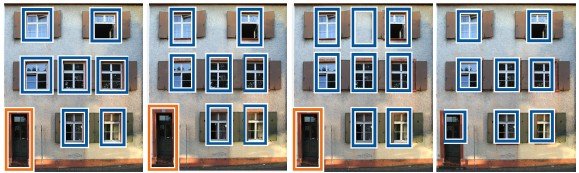
Figure 5: Results for varying parameters. From left to right: groundtruth | results, using the datasets setting λ 1 = λ 2 = 0 . 3 | λ 1 = λ 2 = 1 | λ 1 = 0 . 5 , λ 2 = 0 . 1